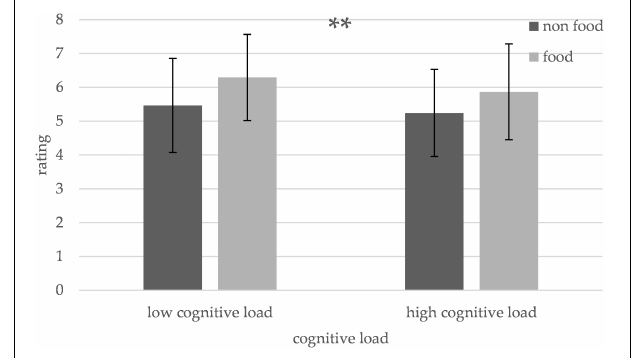
FIGURE 3 | Influence of cognitive load on the intensity ratings for different odors. The intensity ratings of food and non-food odors decrease under high compared to low cognitive load [** p < 0.01, error bars portray one standard deviation (SD)].